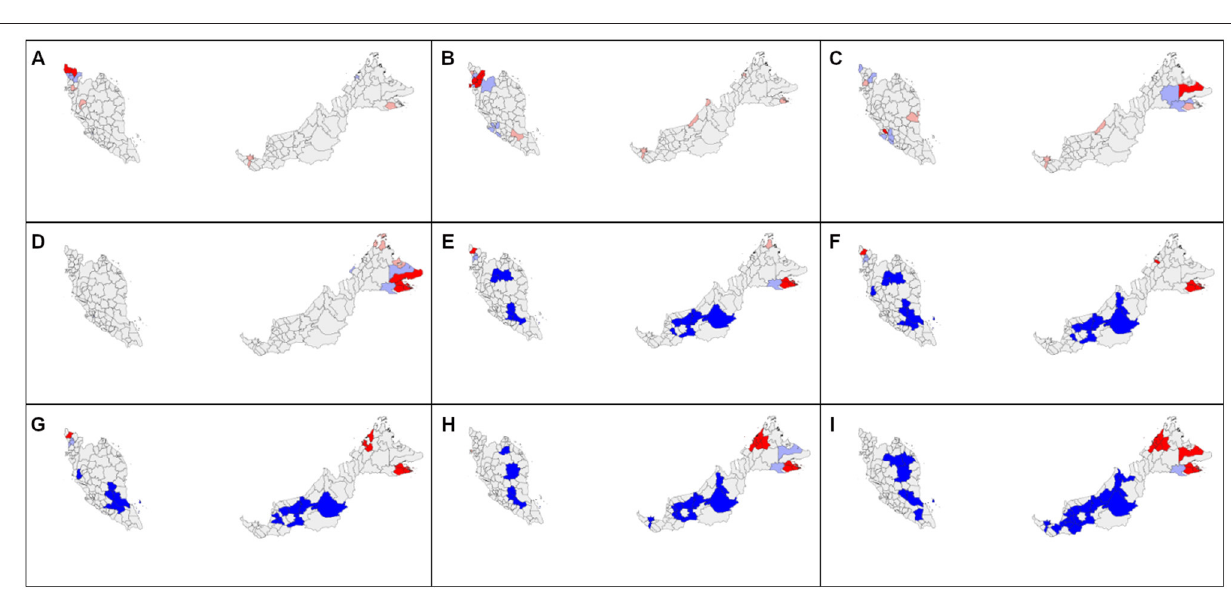
FIGURE 5 | Spatial autocorrelation distribution of COVID-19 new cases by district in Malaysia at cumulative sum of current and 7 days retrospectively in 2020 on (A) August 5; (B) August 22; (C) September 1; (D) September 21; (E) October 5; (F) October 7; (G) October 8; (H) October 19; (I) October 22. Red color indicates high-high cluster, pink indicates high-low, blue indicates low-low, and light blue indicates low-high